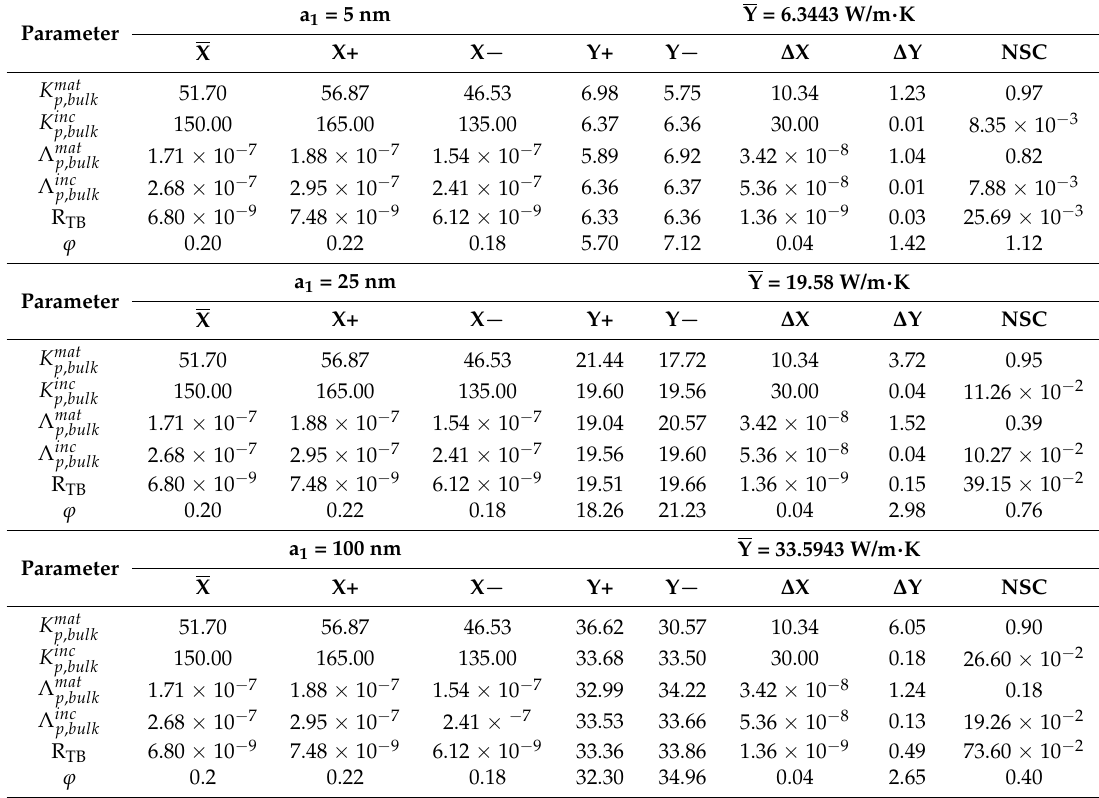
Table 3. Normalized sensitivity analysis results for generalized